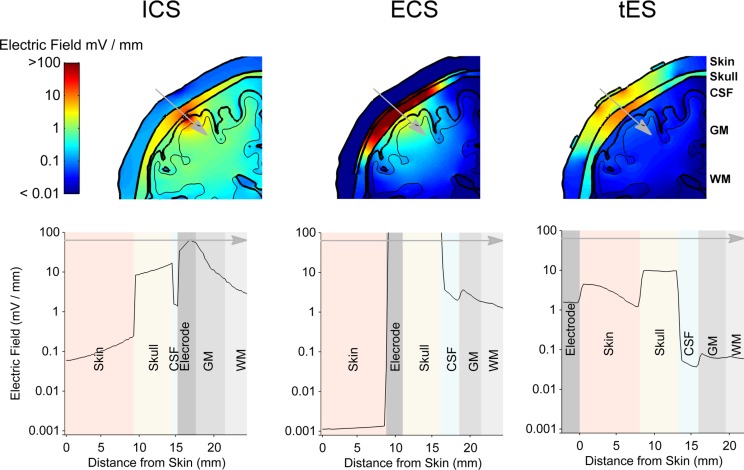
The results from the electro-anatomical computational model comparing the electric field distribution in different tissues resulting from a 1 mA ECS to that of ICS and TES. A 2-dimensional coronal, partial, cross-section is shown in the upper row with the color scale being logarithmic. The different tissues represented in the model are indicated – skin, skull, CSF, gray matter (GM) and white matter (WM). A 1-dimensional plot of the electric field strength along the position indicated by the gray arrow is shown in the lower row. This shows how the electric field magnitude decreases with distance from the electrode and how it is affected by each tissue type. Again, note the logarithmic scale on the axis showing the electric field. ECS shows a more focused and stronger cortical field than TES, but less focused and weaker cortical field than ICS.